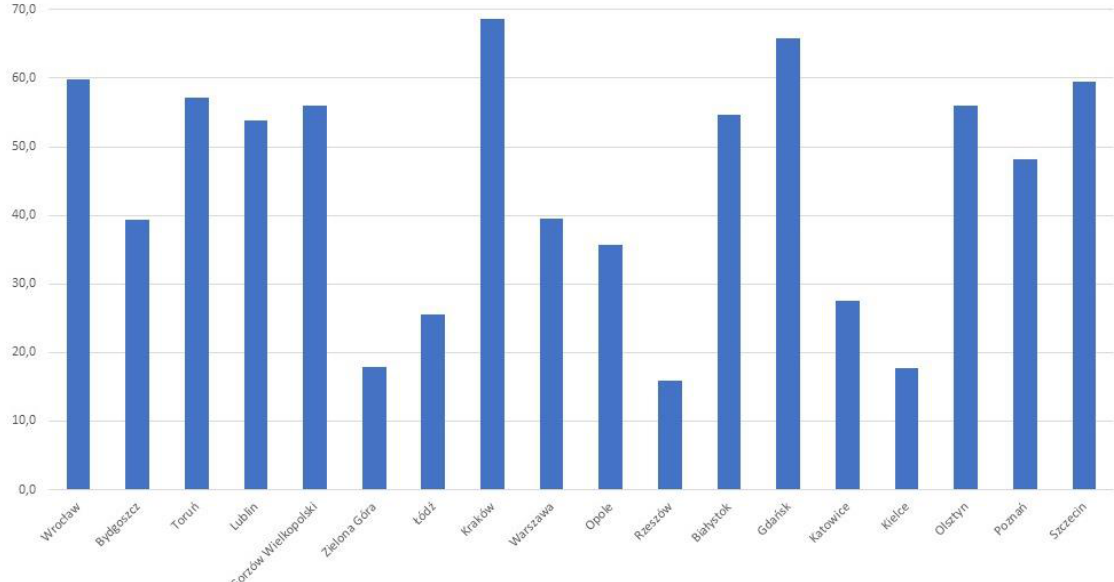
Fig. 4. Share of the area of voivodeship cities covered with local plans in 2020 (Source: own study based on the